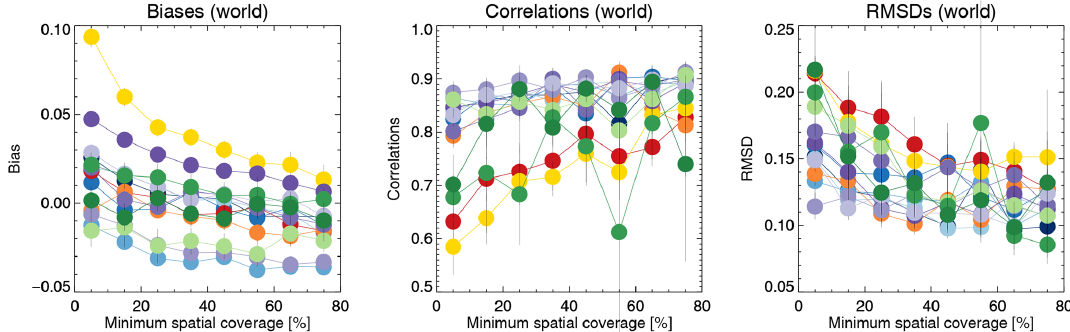
Figure 6. Evaluation of satellite products with AERONET, binned by minimum spatial coverage. Colours indicate the satellite product; see also Fig. 1. Individual collocation of datasets with AERONET (Kinne et al., 2013, selection, pruned) within 1h. Error bars indicate the 5%–95% uncertainty range based on a bootstrap analysis of sample size